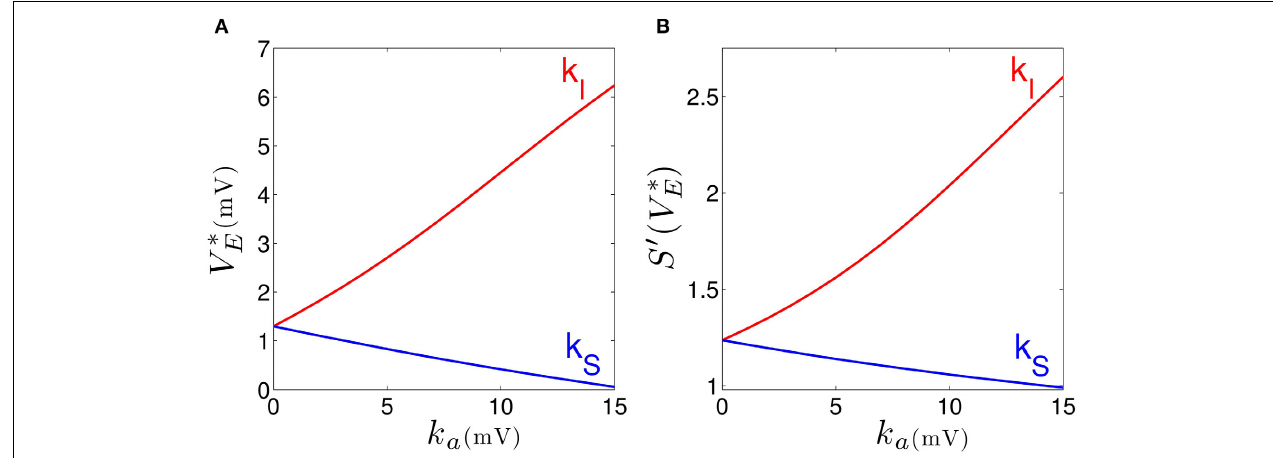
FIGURE 4 | Increasing the tonic inhibition (factor k a for a = I and S ) affects the resting state of excitatory cortical neurons V ∗ corresponding non-linear cortical gain function (B). Here the anesthetic